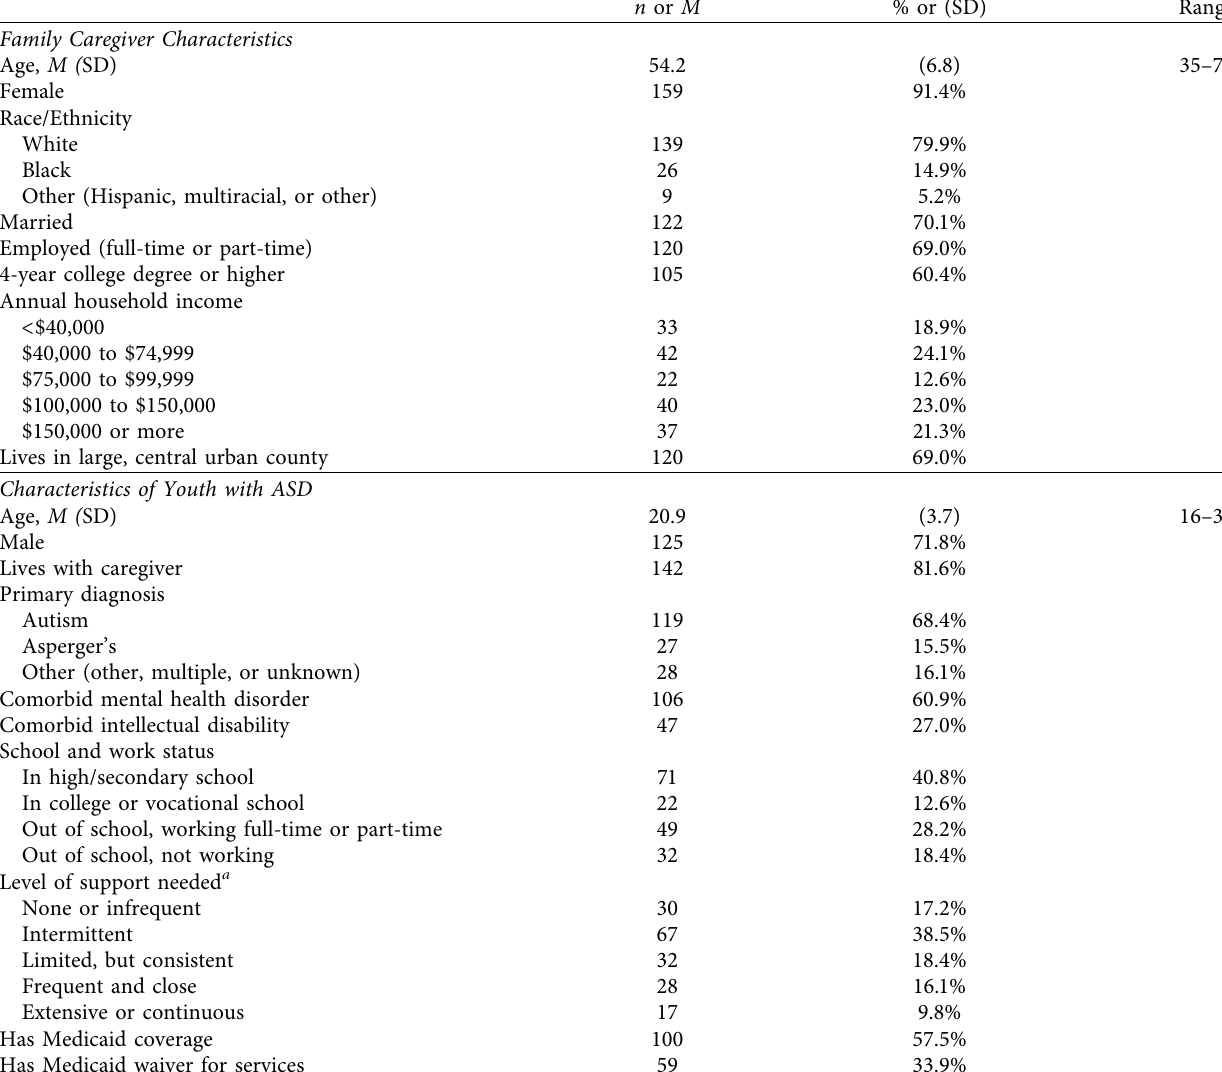
Table 1: Characteristics of family caregivers and youth with ASD ( N �